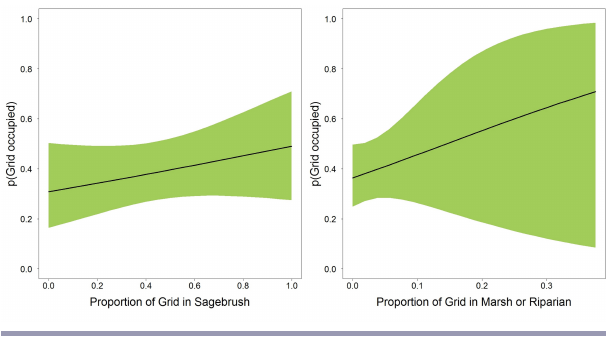
Table 3 . Top model set, and the null model for comparison